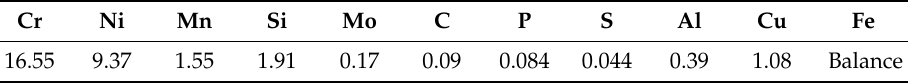
Table 1. Chemical composition of AISI 304 stainless steel (in wt. %).